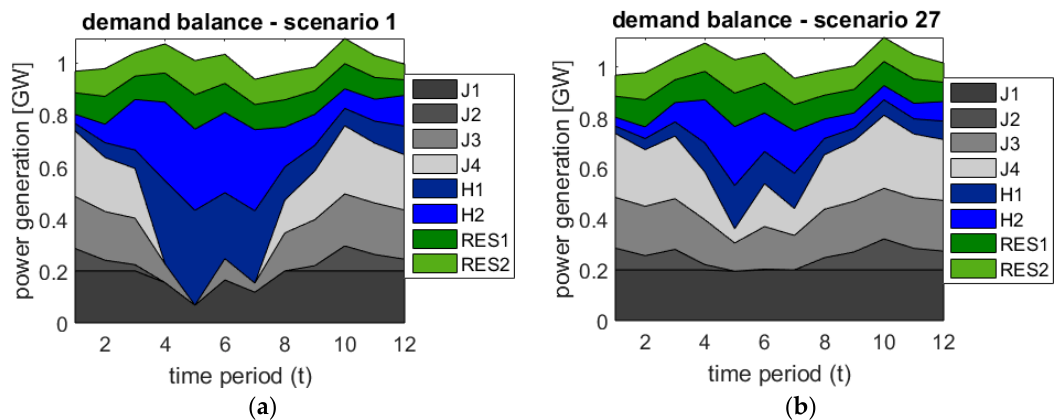
Figure 6. Demand balance for Scenario 1 ( a ) and Scenario 27 ( b ) for the centralized case.